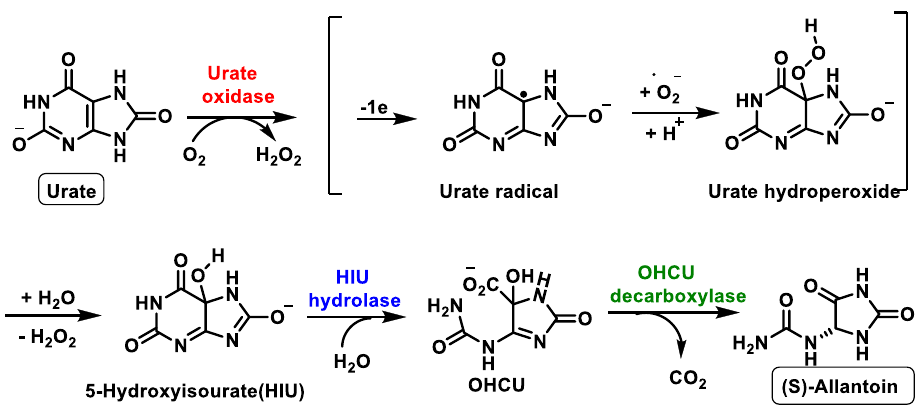
Figure 10. Schematic representation of the ureide pathway.